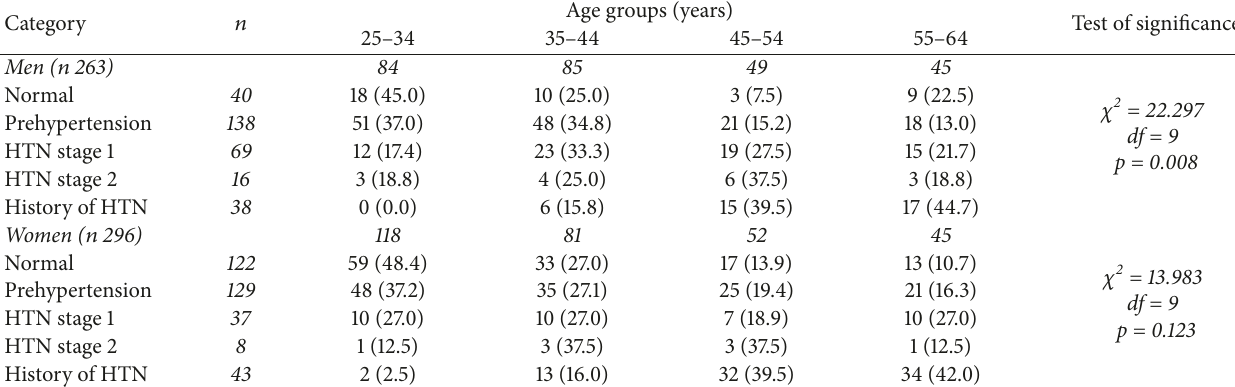
Table 4: Prevalence of hypertension and prehypertension by gender and age groups among the study subjects ( 𝑁 640).